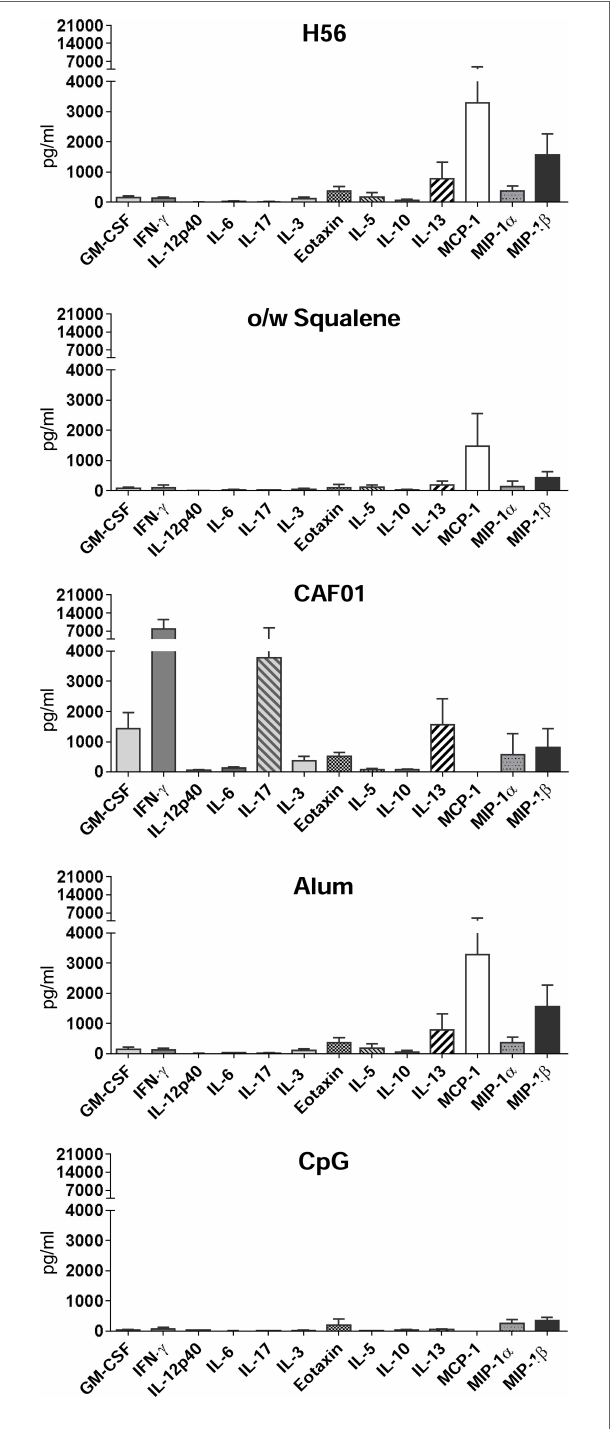
FigUre 3 | cytokine/chemokine production in splenocyte culture supernatants . C57BL/6 mice were subcutaneously immunized with H56 alone (H56) or combined with different adjuvants (o/w squalene, CAF01, alum, and CpG), and spleens were collected 7 days after immunization. Cytokine secretion was detected upon 3 days of H56 antigen restimulation by Luminex immunoassay. Values, expressed as picograms per milliliter, are reported as the arithmetic mean ± SD of H56-stimulated minus the respective unstimulated samples, of five animals per